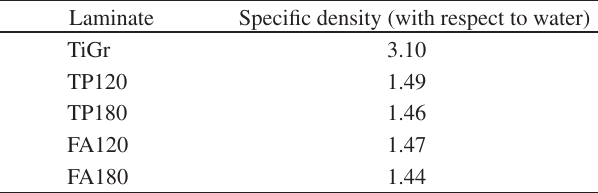
Table 1. Specific weight (dimensionless) of the tested laminates.